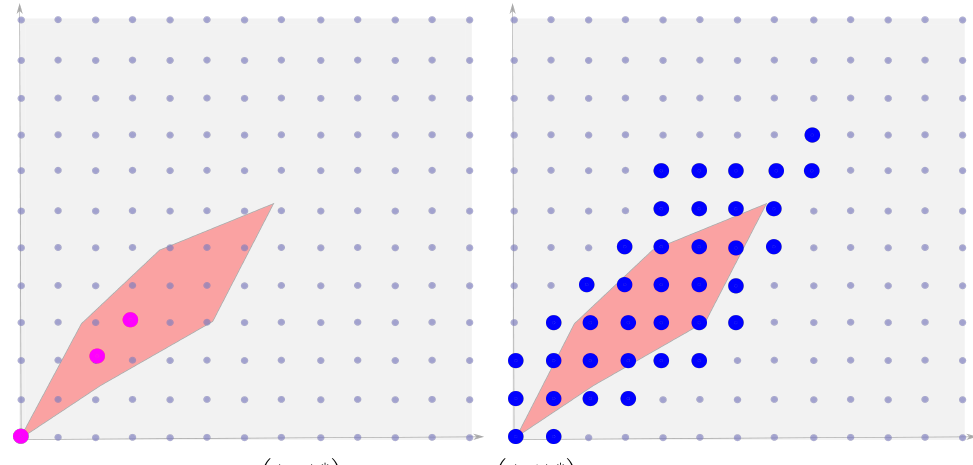
Figure 2. Fixed points Fix